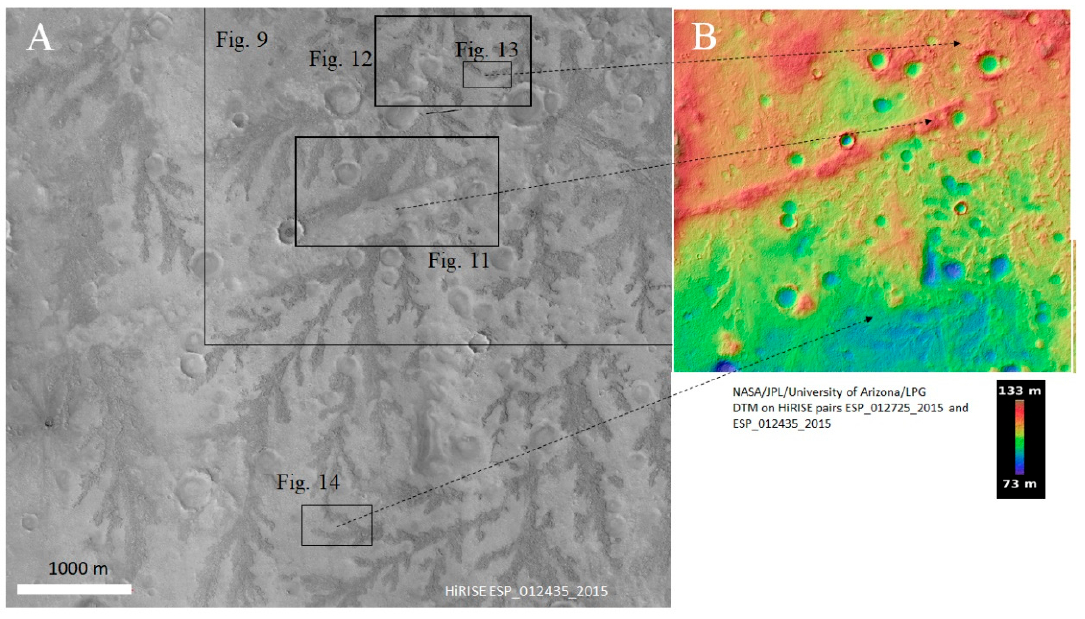
Figure 10. ( A ) HiRISE image of the central part of the dendrites (the area shown here is marked in Figure 6A). ( B ) DTM of the same area based on wider image released by the Lunar and Planetary Laboratory of the University of Arizona based on HiRISE stereo pairs ESP_012725_2015 and ESP_012435_2015 (https://www.uahirise.org/dtm/dtm.php?ID=ESP_012725_2015, accessed on 31